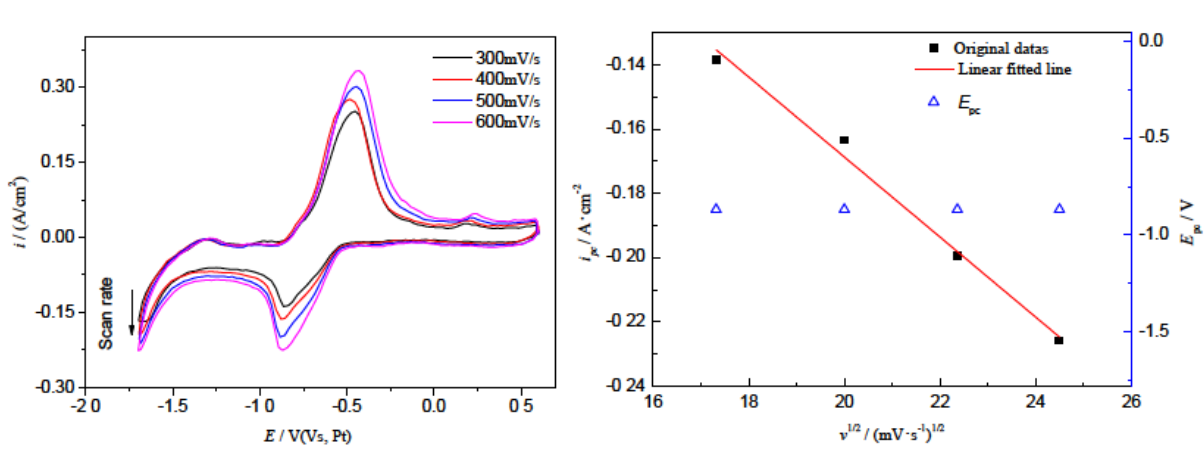
Figure 7: Cyclic voltammetry curve of NaCl-KCl-NaF-HfO 2 at different scanning speeds (a) Cyclic voltammetry curve (b) i pc ~ v 1/2 & E pc ~ v 1/2 curve (rate scan: 300~600 mV/s, vs.